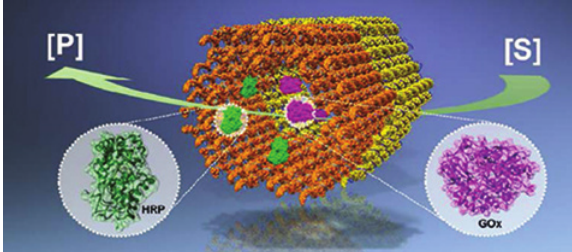
Figure 4: Scheme of an enzymatic reactor build from DNA and enzyme molecules. Enzyme molecules are attached with precision on the highly modulated DNA nanostructures. Glucose oxidase (GOx, purple) and horseradish peroxidase (HRP, green) have been assembled into two tubular DNA origami nanostructures (orange and yellow cages). The reaction cascade starts with the production of hydrogen peroxide from glucose oxidase, which is the substrate for peroxidase-mediated oxidation. This figure was taken from Linko et al.